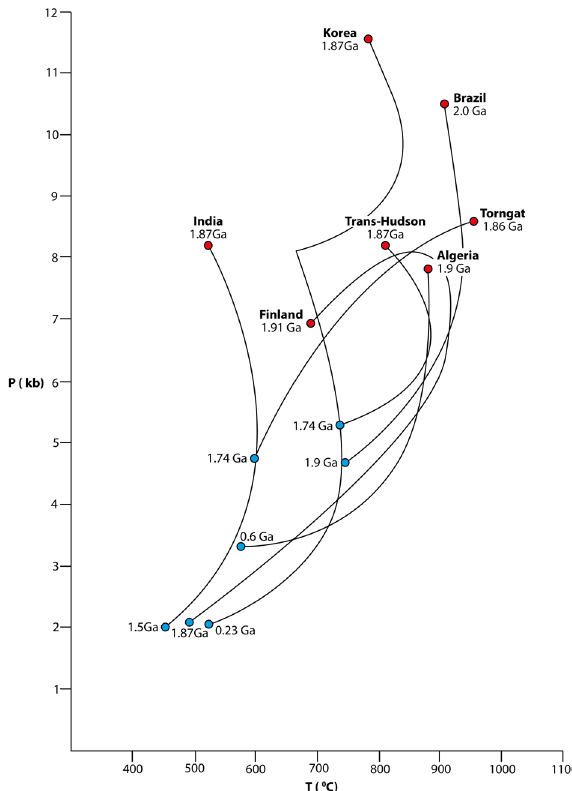
Fig. 7 Pressure-temperature (P-T) trajectories for pelitic granulites in Palaeoproterozoic orogens. Typically, trajectories pass from hot (>800 °C) temperatures (red circles) during crustal thickening to cooler temperatures (blue circles) during exhumation. Note range of timescales from thickening to exhumation from rapid to over a billion years.